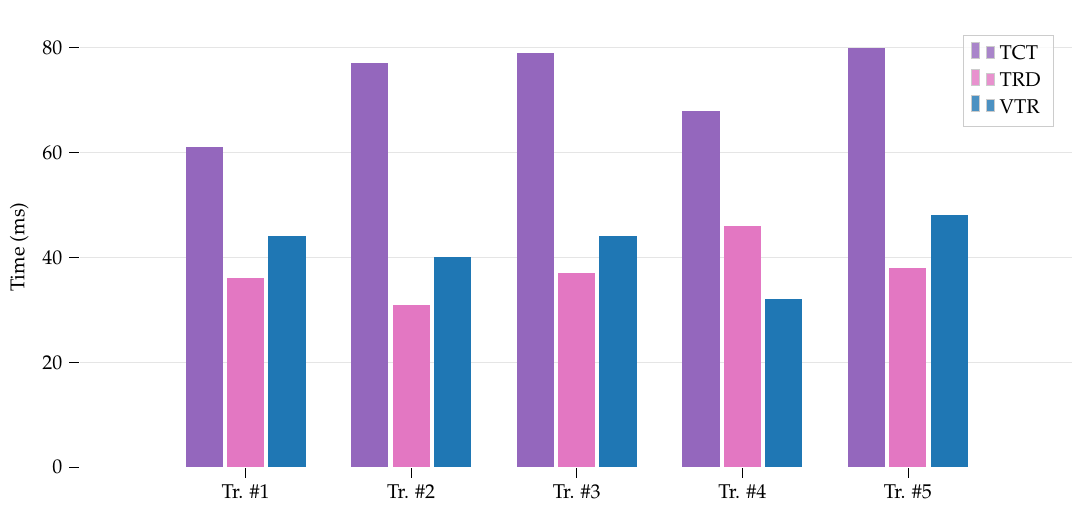
Figure 5. Latencies to retrieve mata data (TRD), transaction validation time (VTR) needed for